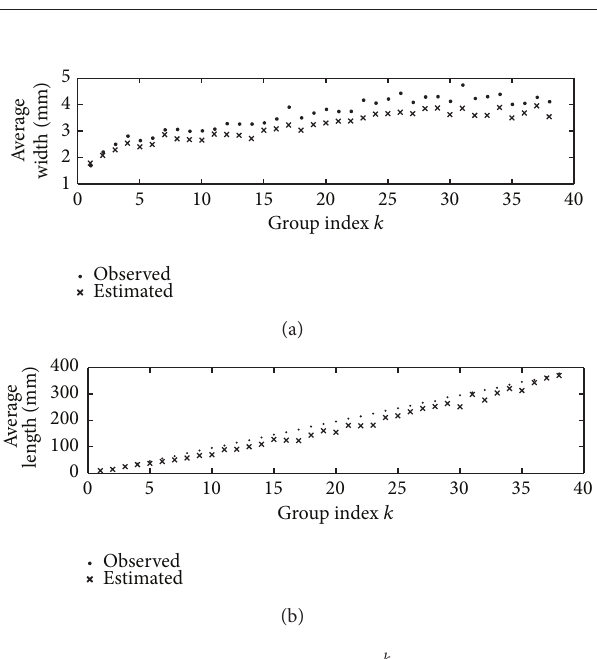
Figure 1: (a) Comparison of observed ℎ ℎ 𝑘 𝑑 width averages taken over groups 𝑘 observed 𝑙 𝑜 and image estimated groups 𝐺 𝑘 (𝑙) (see Table 6). The values obtained from digitized leaves were estimated by using ST (68)